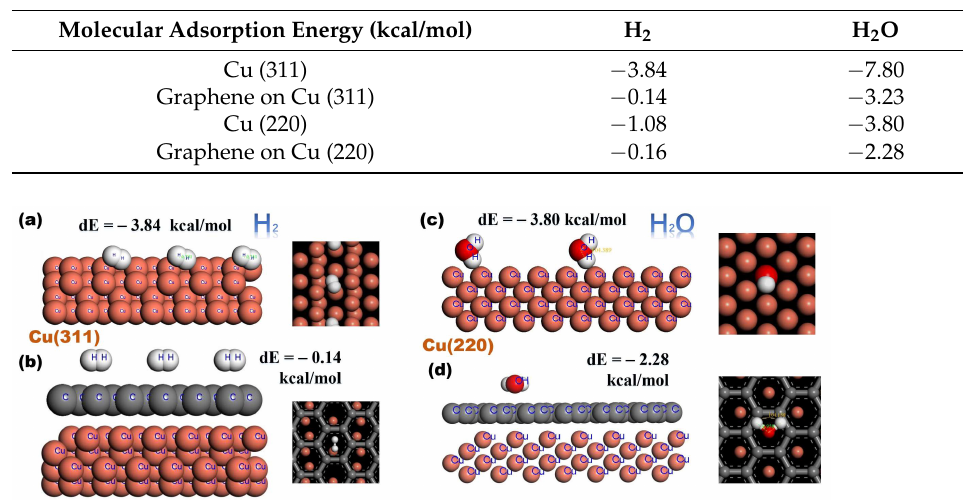
Table 1. Molecular adsorption binding energy of two typical gas molecules at different crystal directions and modified state interfaces. Molecular Adsorption Energy (kcal/mol)